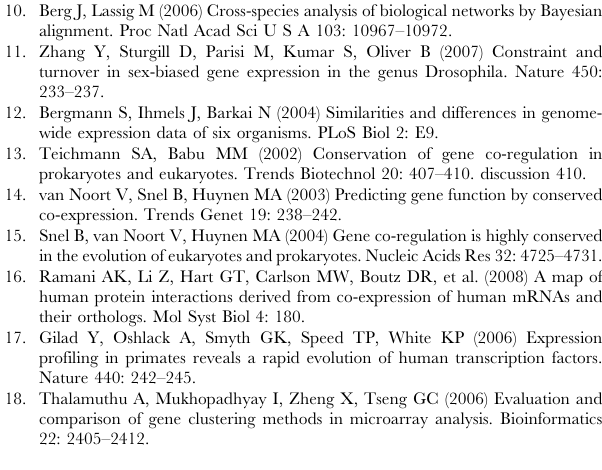
Figure S2 SCSC clusters of mouse and human ES cell differentiation. (A) Sample information for human ES cells. (B) The number of orthologous probe sets in each result cluster, and (C) the corresponding expression patterns of mouse and human clusters. Each dot represents the mean expression of a cluster in a biological replicate. Figure S3 Performance evaluation with independent experi- mental data. The consistency of a clustering result to a set of co- regulated gene groups is measured by biological homogeneity index (BHI). K-means clustering was run 10 times with different initial values. The red bars and their error bars represent the average BHI and the standard deviation for these 10 runs. The best performance out of the 10 runs is also reported (yellow bar). Two test sets of co-regulated genes groups were defined as follows. Set 1: Co-regulated genes were defined as the genes whose expression levels were affected by all of the seven RNA knockdown (RNAi) experiments of seven regulatory proteins (OCT4, SOX2, NANOG, ESRRB, TBX3, TCL1, DPPA4) which maintain ES cell identity. Each RNAi experiment provided a list of genes whose expression was affected. Taking the intersection of the seven gene lists, a total of 60 genes were identified as regulated by all seven ES cell regulators. These 60 genes were used as the first test set. Set 2: Co-regulated genes were defined as the genes whose expression was affected by RNAi knockdown of all four of the transcription factors NANOG, OCT4, SOX2 and ESRRB, and for which the direction of expression change was the same. These four transcription factors physically interact and synergistically regulate gene expression in ES cells. Two groups of co-regulated genes were identified. Group 1 contained 107 genes that were consistently induced by the RNAi of each of the four factors, whereas group 2 contained 48 genes that were repressed by all four RNAi treatments. These two co-regulated gene groups constitute the second test set.